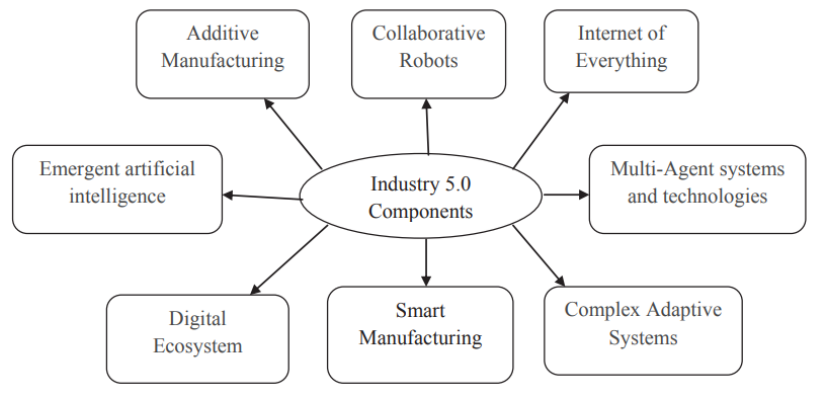
Figure 4. Technologies supporting I5.0 [53].